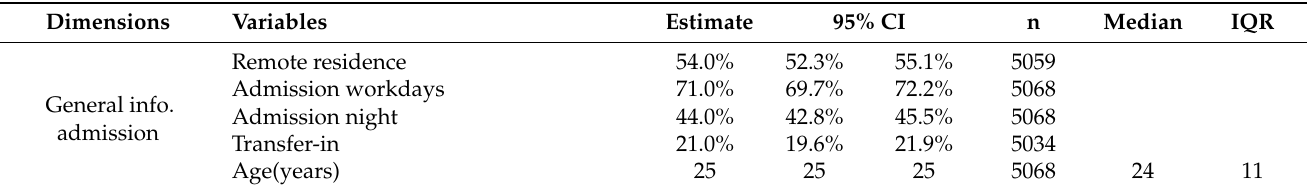
Table A1. Obstetric cases extended demographic and clinical profile, Chicuque , Chokwe and